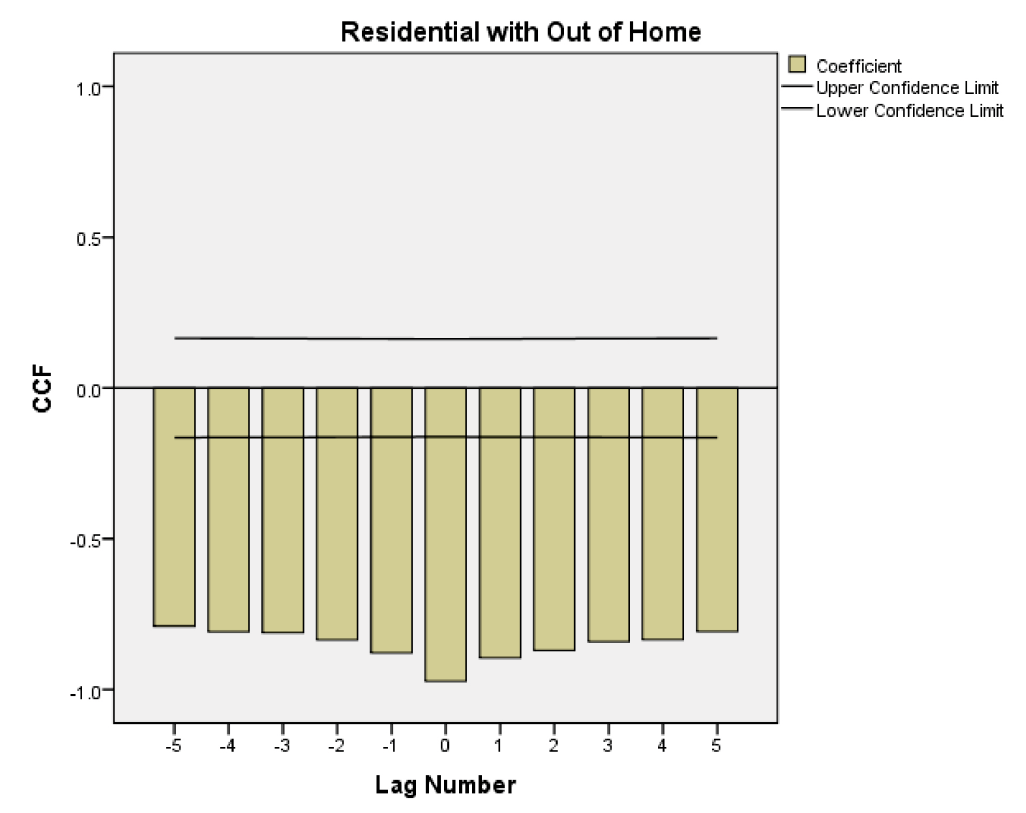
Figure 3: Cross Correlation Functions for PDB for Residential Areas and